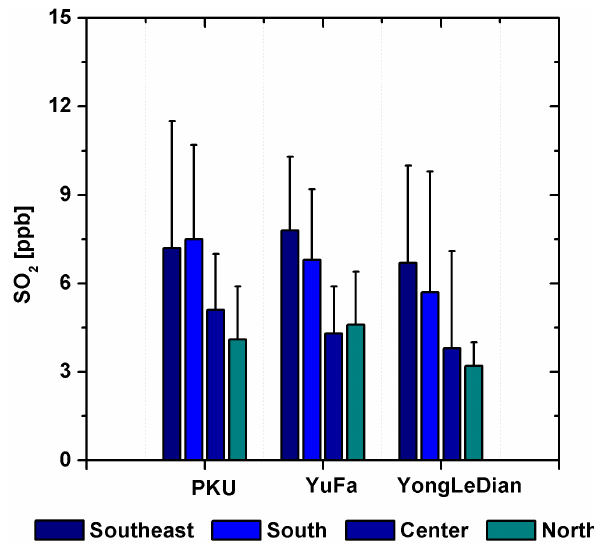
Fig. 4. The average concentrations of SO 2 measured at PKU, YuFa and YongLeDian sites subdivided on the basis of four directions of backtrajectories from 1 August to 15 September, 2008. The bars show the standard deivations of SO 2